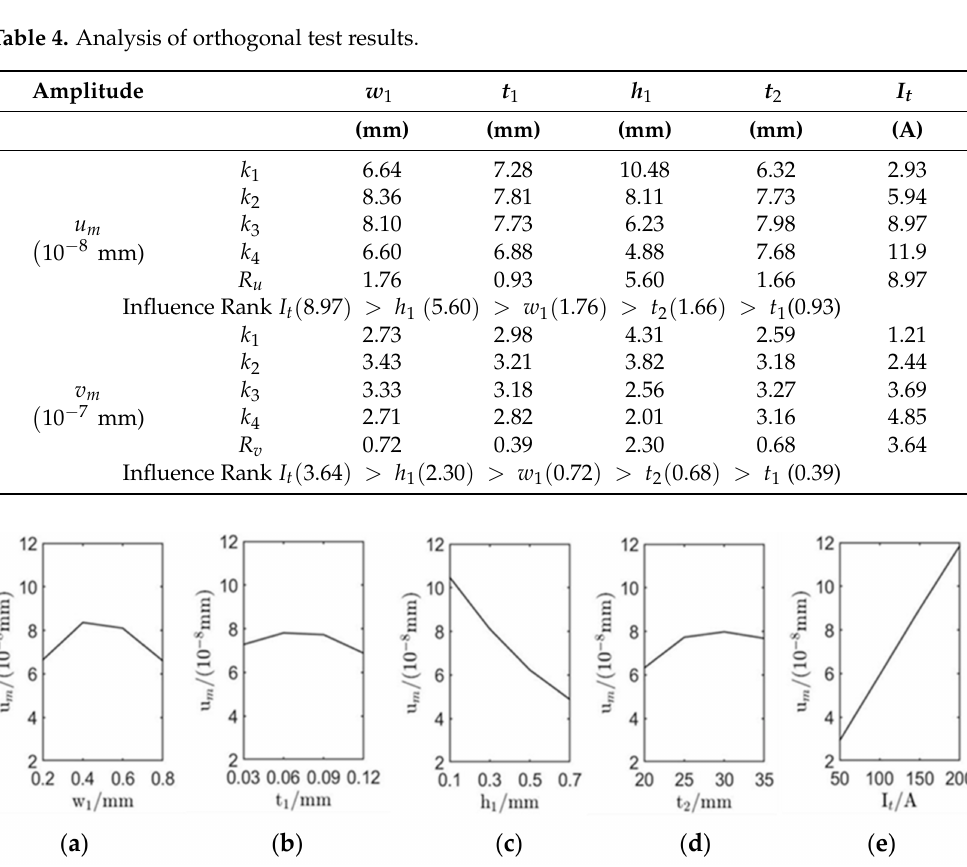
Figure 5. Influence of varying the EMAT design parameters on the amplitude of in-plane displace- ment of surface waves: ( a – e ) successively show the influence of coil width w 1 , coil thickness t 1 , coil lift distance h 1 , permanent magnet thickness t 2 , and excitation current peak value I t on the amplitude of in-plane